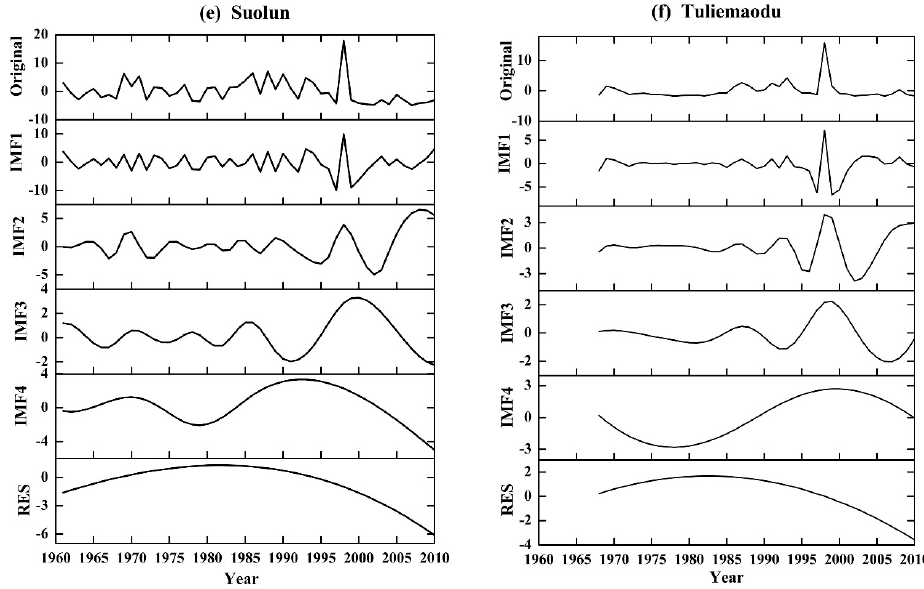
Figure 3. The Intrinsic Mode Function and trend component of streamflow anomaly at six gauge stations (( a ) Beian, ( b ) Shihuiyao, ( c ) Xiaoergou, ( d ) Zhalantun, ( e ) Suolun and ( f ) Tuliemaodu) during 1961–2010 in the headwater region of the Nejiang River Basin, Northeast China.